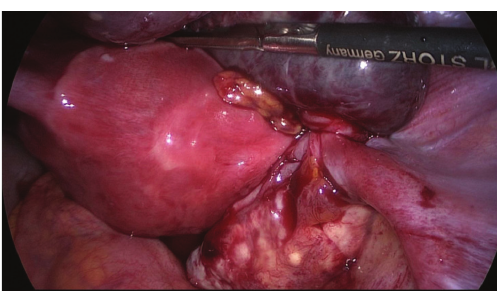
Figure 2: Fallopian tube torsion.